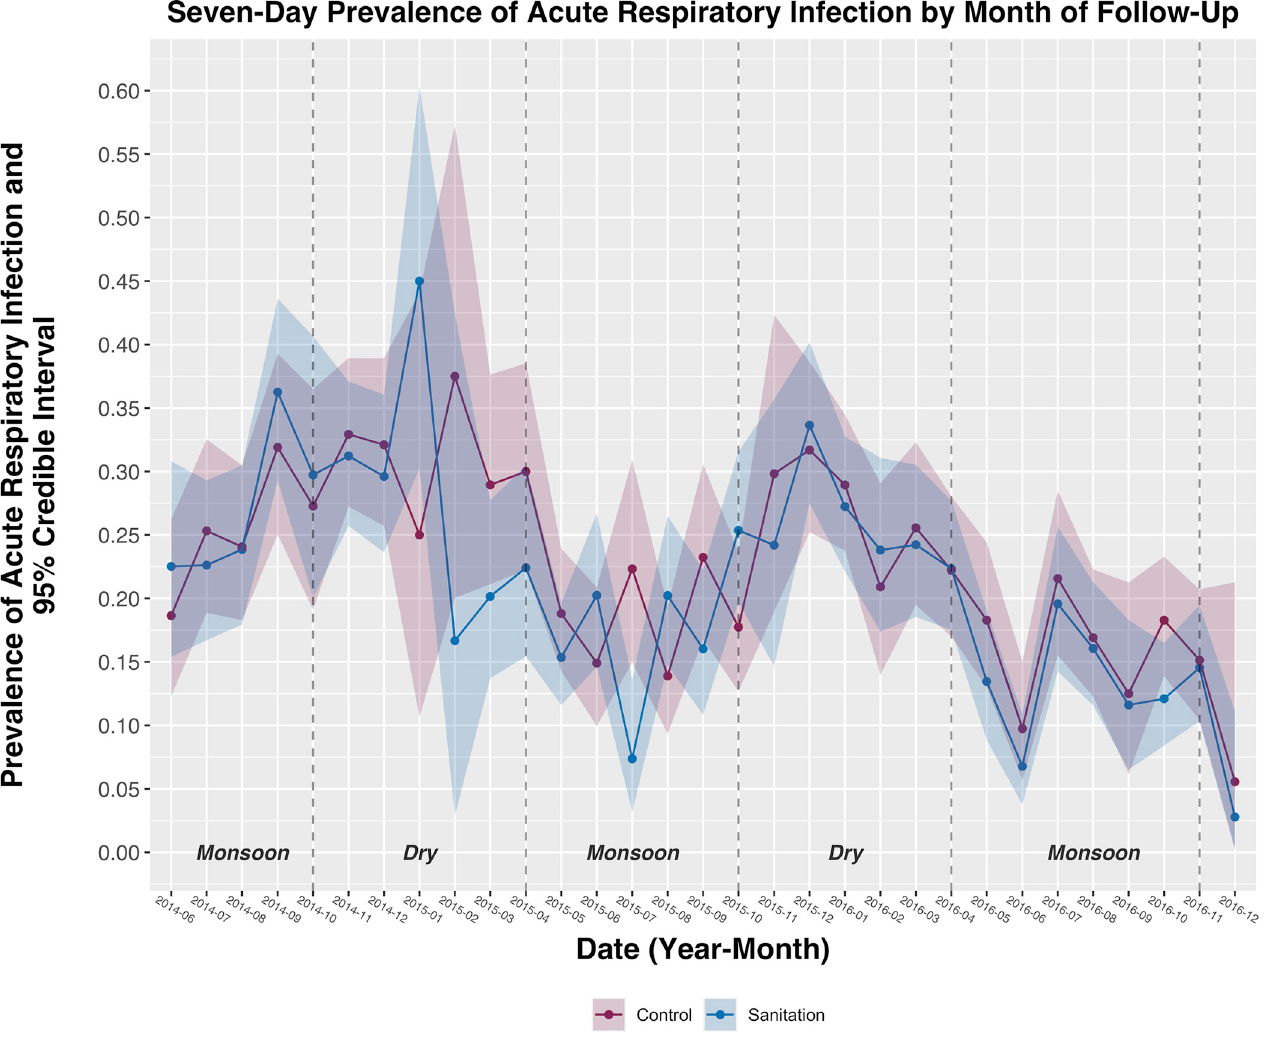
Fig 3. Prevalence of ARI among children under 5 years by intervention arm and month of follow-up. AU : AbbreviationlistshavebeencompiledforthoseusedinFig 3 andTables 1 and 2 : Pleaseverifythatallentriesarecorrect : Shaded bands represent 95% credible intervals around each prevalence estimate. Monsoon and dry seasons are indicated with vertical dashed lines. ARI, acute respiratory infection.